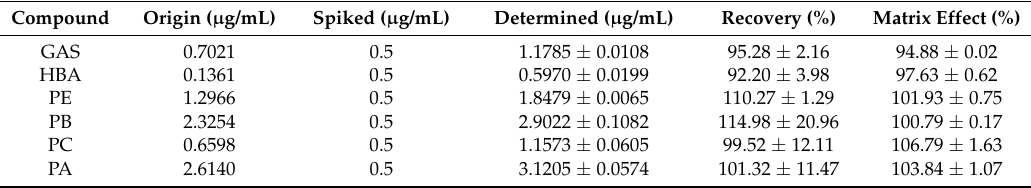
Table 2. The extraction recoveries and matrix effects of GAS, HBA, PE, PB, PC and PA.